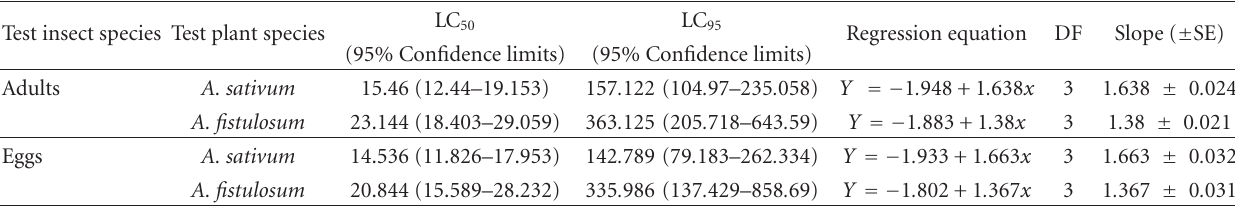
Table 2: Fumigant toxicity of test essential oils to C. maculatus adults and eggs.